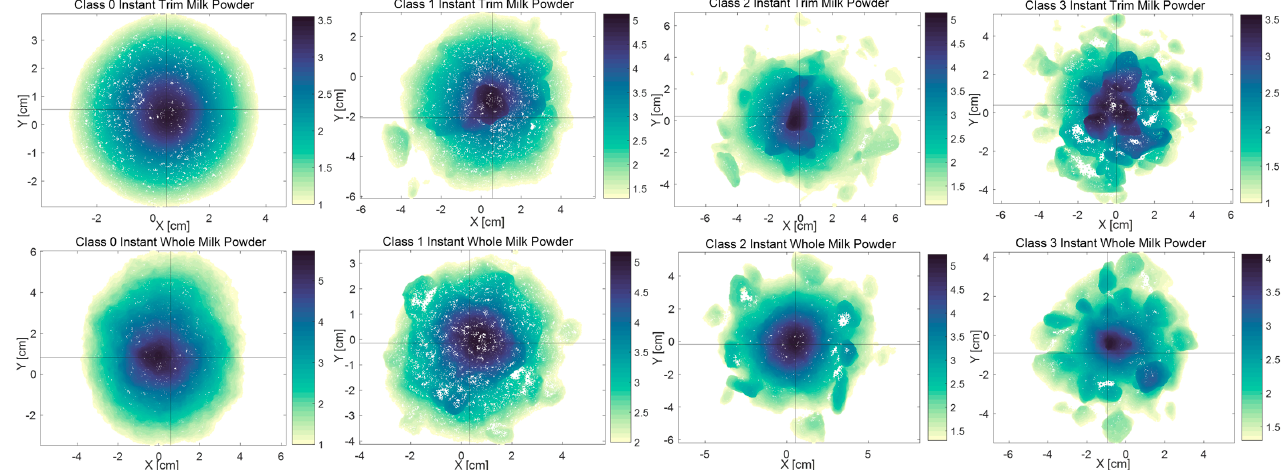
Figure 8. The 3D digital model top views of Class 0–3 milk powder samples. All contours (40 layers) for a Class 0 sample and a Class 3 sample are separately